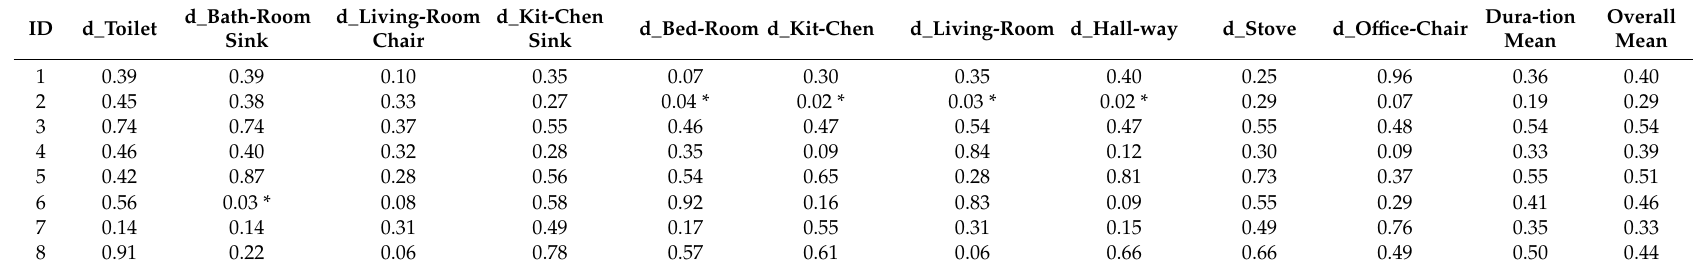
Table 5. Paired t -test results for within-home behavior comparisons. (* = Result is statistically significant ( p < 0.05).).